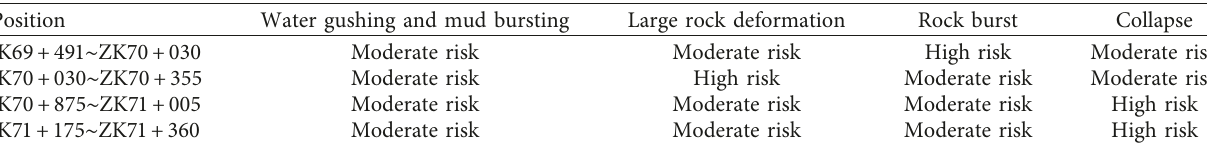
Figure 5: Cloud droplet diagram. Table 9: Risk levels of each